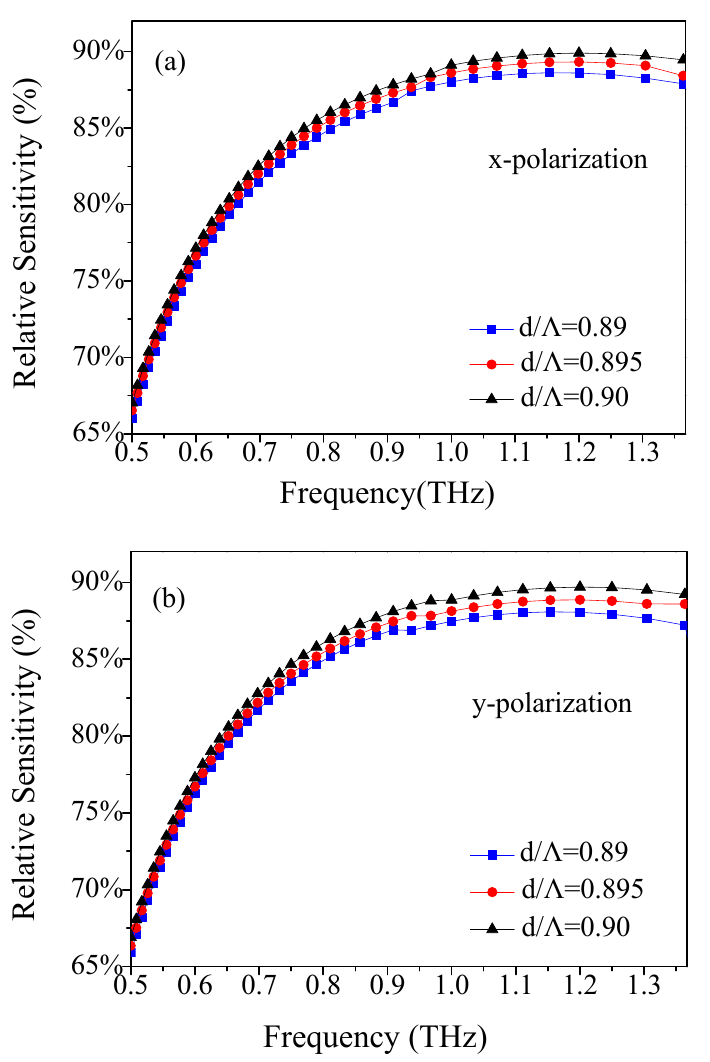
Figure 3. Frequency dependence of the relative sensitivity of ( a ) x- and ( b ) y-polarization for air– filling ratio d / Λ .